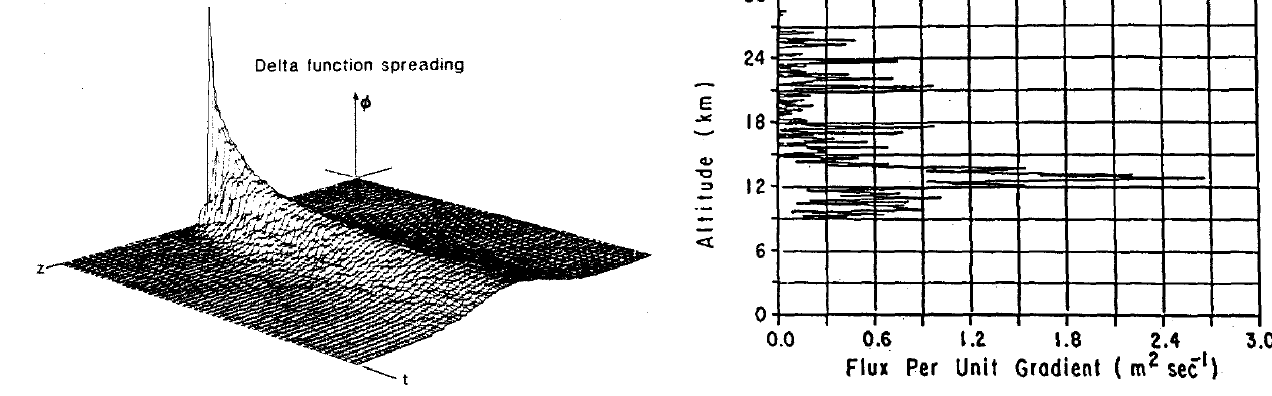
(Fig. 11). They found K θ ≈ 0 . 2 − 0 . 5 m 2 /s, with peak values of ∼ 2 m 2 /s.